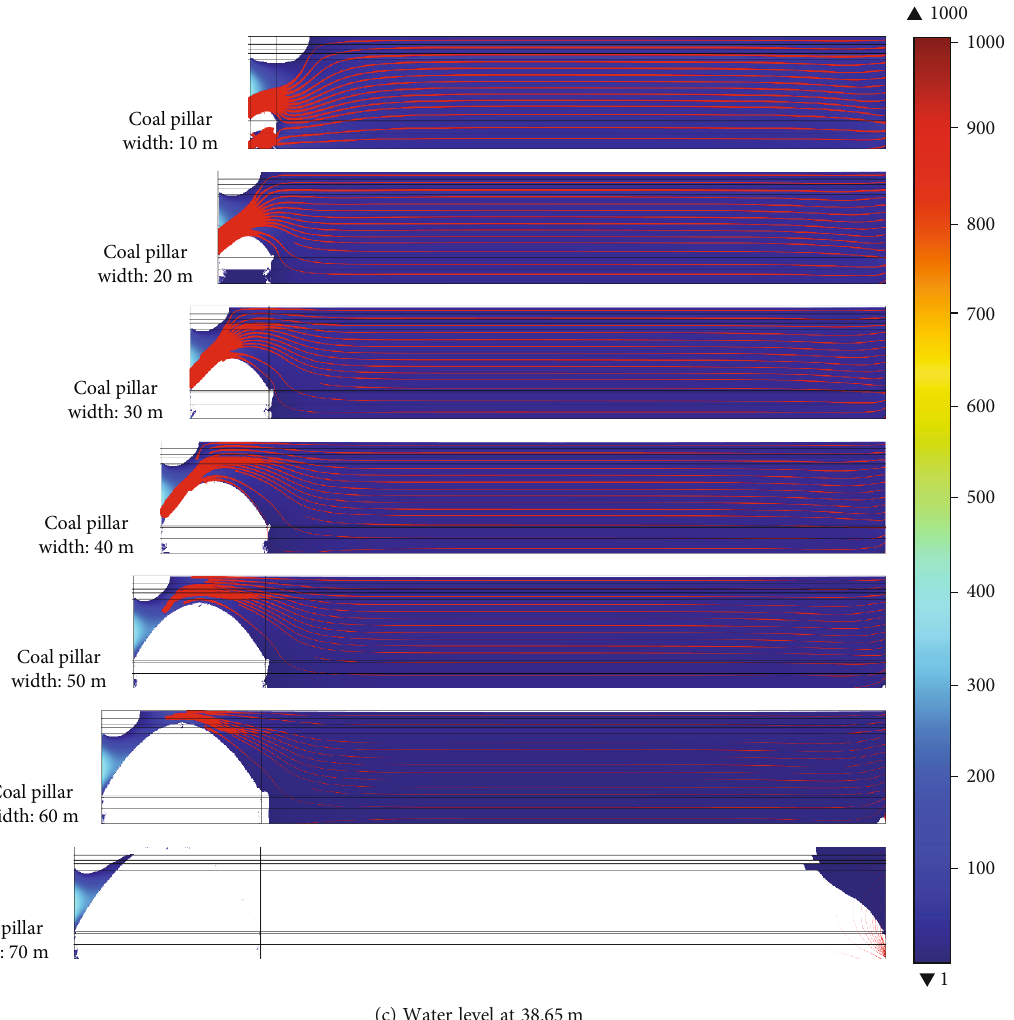
Figure 7: Cloud map of ratio r and water trace of goaf at di ff erent water levels and coal pillar widths. (a) Water level at 18.65m. (b) Water level at 28.65m. (c) Water level at